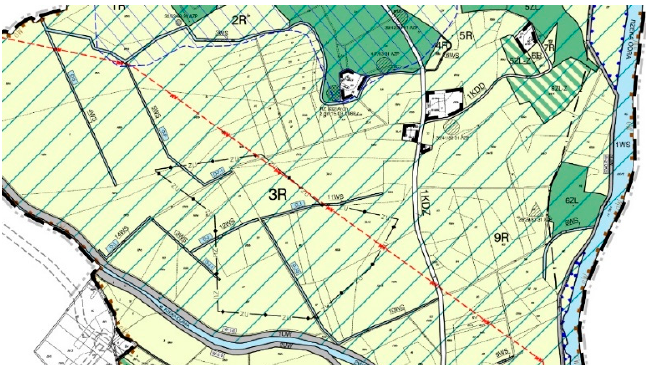
Figure 3. A fragment of the planning study supporting agricultural and forest functions, with the prohibition of building the presented areas, taking into account the natural routes of drainage ditches and flood embankments from the river bed. Source: [27].